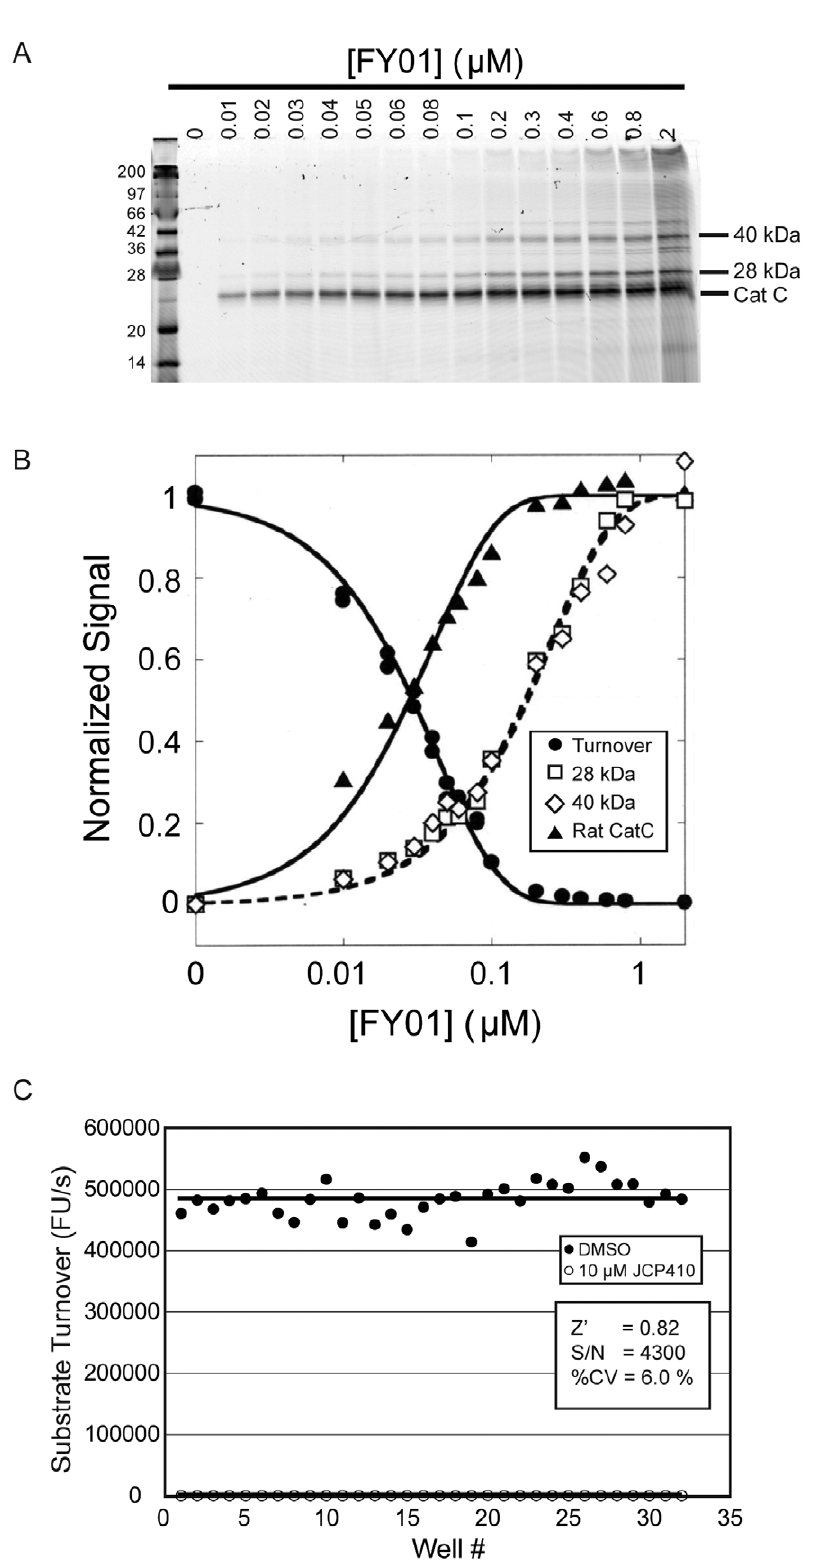
Figure 3. Cat C-specific fluorogenic assay in rat liver lysates. A. Labeling of Cat C with FY01. Rat liver extract extracts were treated with increasing concentrations of FY01 for 1 h and labeled proteins analyzed by SDS-PAGE followed by scanning of the gel using a flatbed laser scanner. The location of labeled Cat C is indicated. B. Inhibition of substrate turnover specifically correlates with Cat C labeling. The cleavage of (Pro-Arg) 2 -Rho substrate was measured prior to analysis of FY01 labeling shown in part A. Quantification of the indicated labeled proteins relative to DMSO control is shown. C. Cat C-specific HTS assay in rat liver extracts. Rat liver lysates were treated for 30 min with either DMSO or JCP410 (10 m M) followed by the